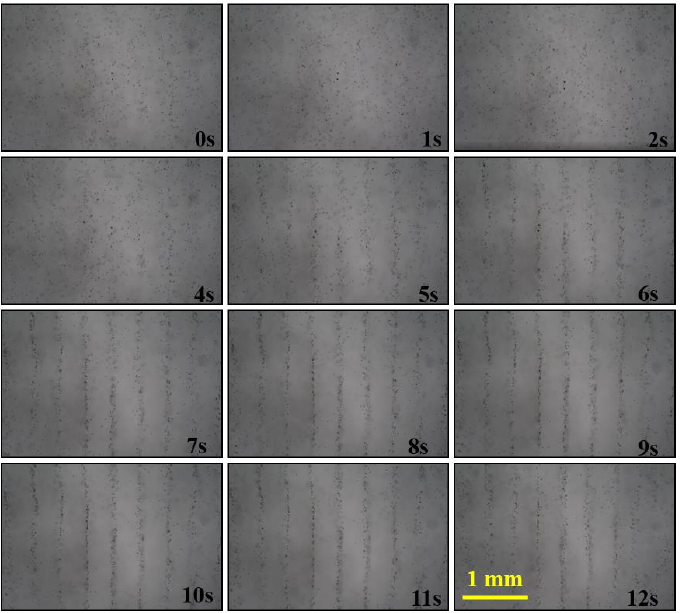
Figure 10. Recordings illustrating the process of particle arrangement actuated by the IEM mode with 2 MHz.